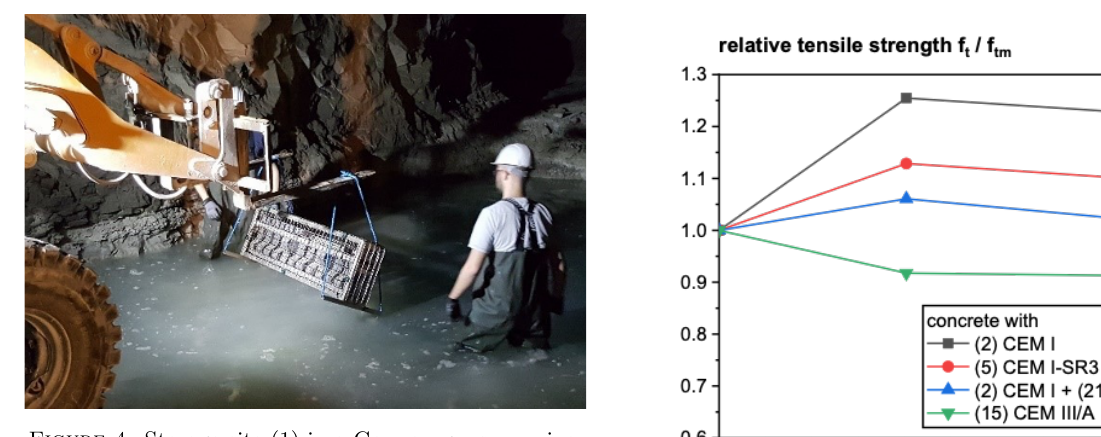
Figure 4. Storage site (1) in a German gypsum mine.